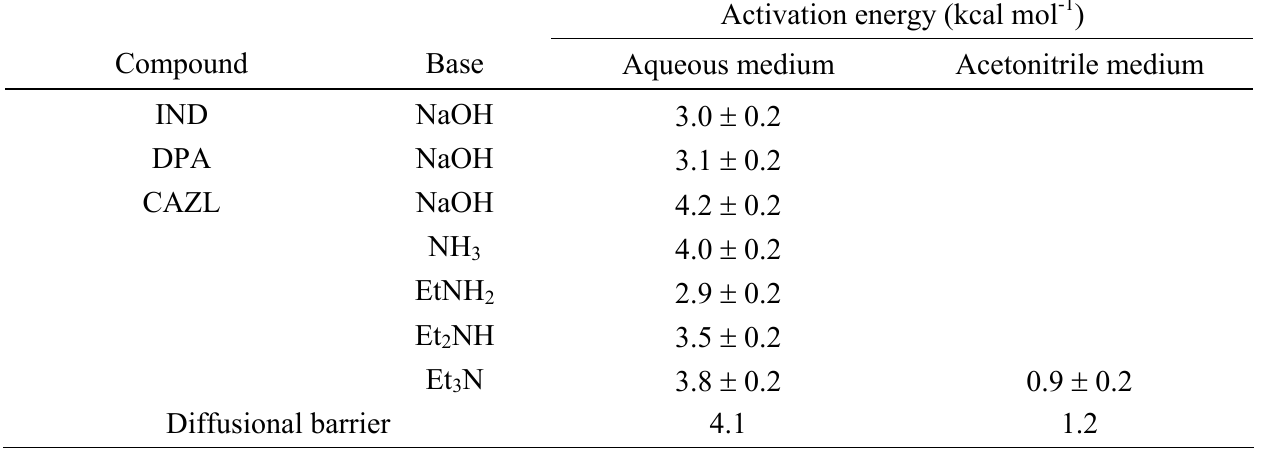
Table 5. Activation energies for different deprotonation